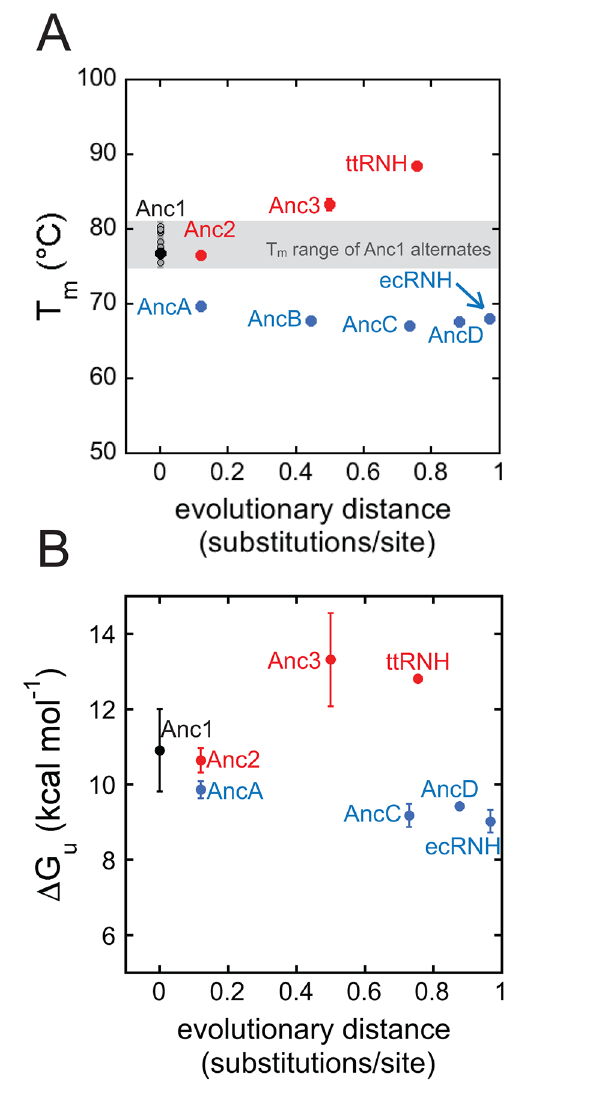
Figure 3. Thermophilic and mesophilic lineages exhibit oppo- site stability trends. Starting with the shared ancestor, Anc1, stabilities increase along the thermophilic lineage and decrease along the mesophilic lineage. (A) Melting temperature of the maximum likelihood ancestors and the ten alternate reconstructions of Anc1 as a function of evolutionary distance from the last common ancestor, Anc1. Distances are calculated as the sum of the branch lengths connecting Anc1 to the protein of interest. The grey region defines the range of T m s measured for the Anc1 alternates, which appear individually as grey data points. The error bars are one standard deviation. (B) Average D G s at 25 u C as a function of evolutionary distance from Anc1. Error bars are one standard deviation. See also Table S1 and Dataset